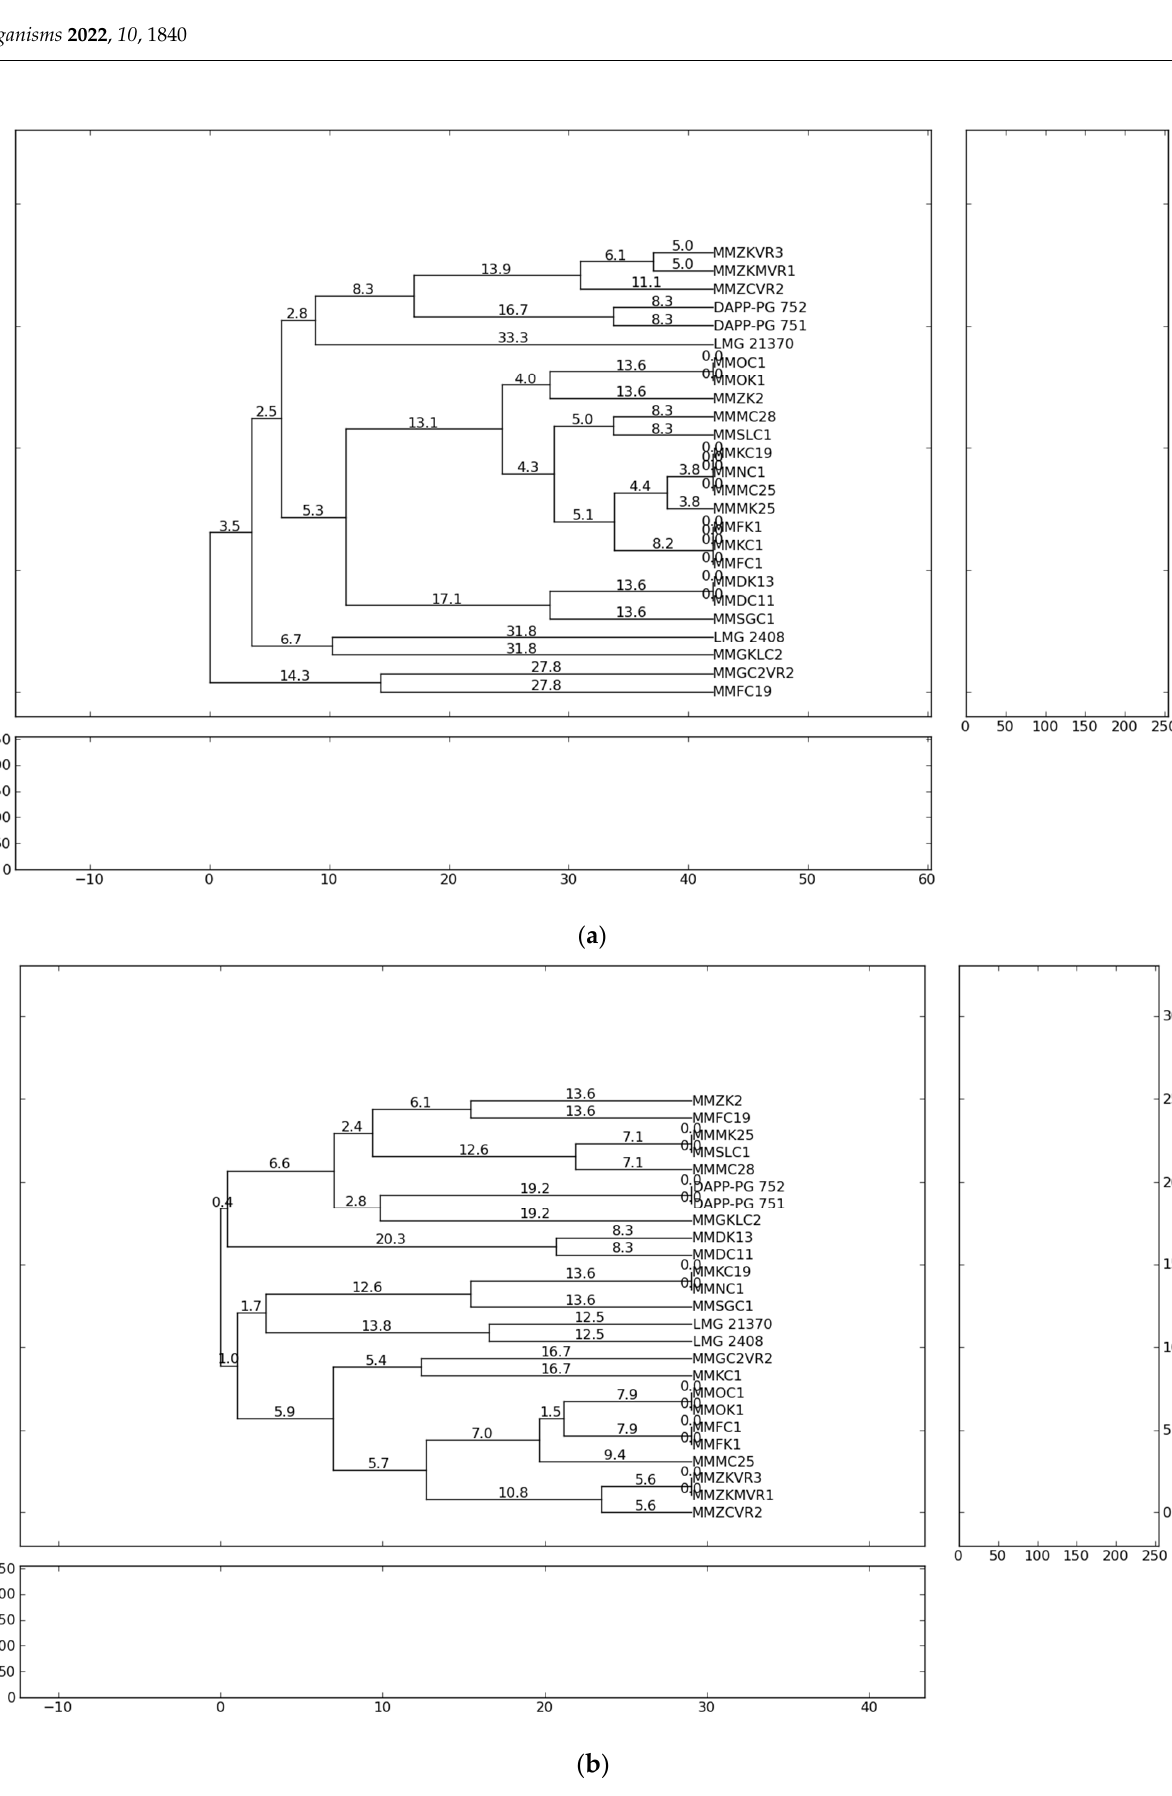
( c ) Figure 1. Dendrogram generated using UPGMA clustering method based on ( a ) ERIC-PCR, ( b ) BOX-PCR and ( c ) REP-PCR results for 21 isolates from Serbia and four reference strains. Genetic